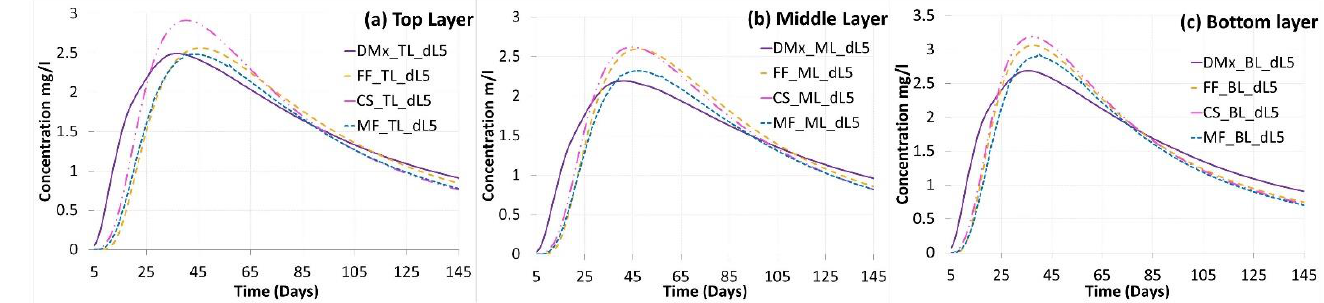
Figure 6. Simulated tracer concentration using MODFLOW/MT3DMS, FEFLOW, COMSOL Multiphysics, and DuMu X at three different layers for Problem 3; ( a ) top layer; ( b ) middle layer; ( c ) bottom layer with a dispersivity value of 5 m.